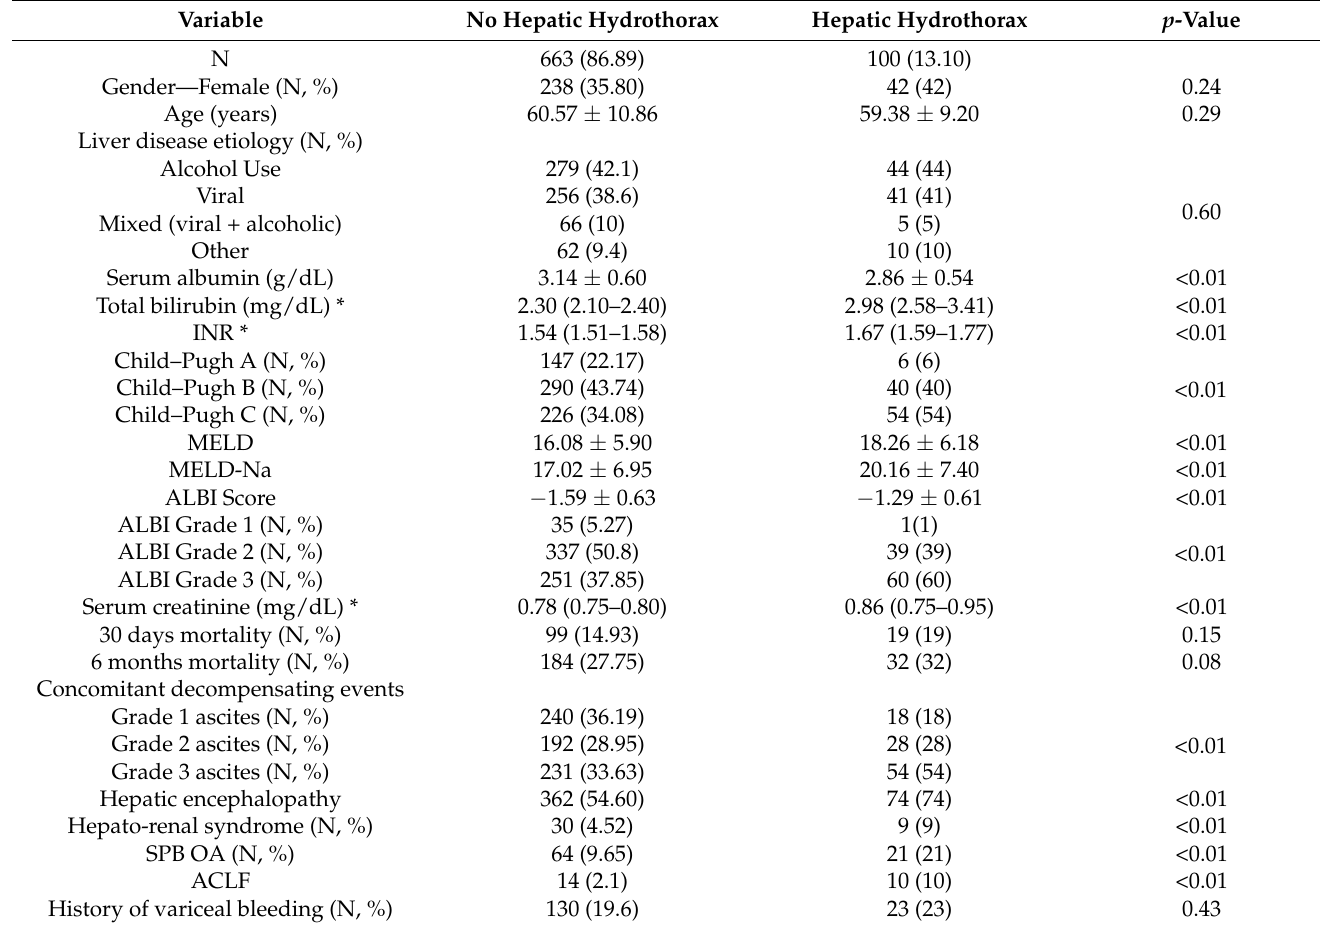
Table 1. Comparison between groups based on the presence or absence of hepatic hydrothorax.